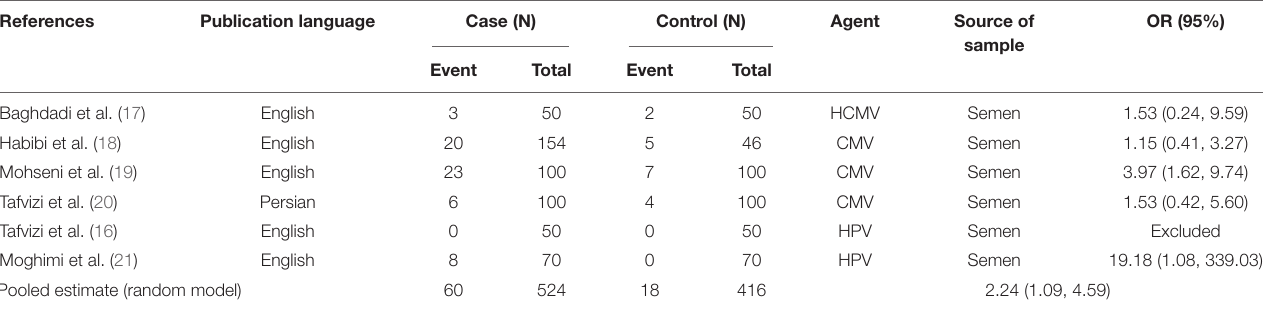
TABLE 1 | Case-control virus studies included in the